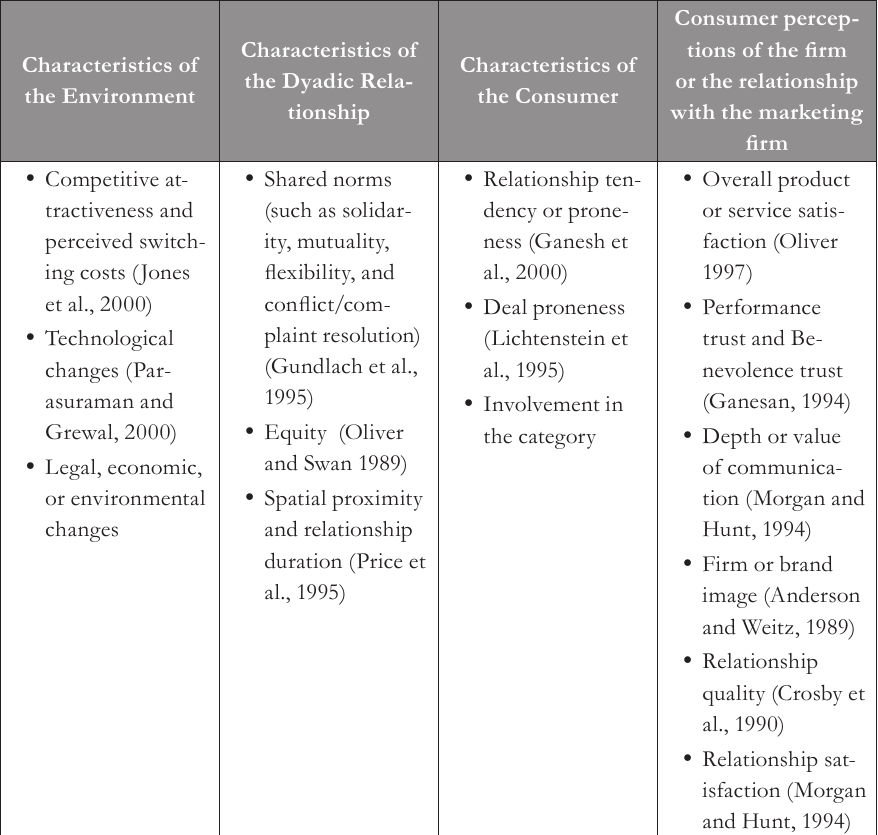
Fig. 1 - Classification of Customer Loyalty Antecedents. Source: Ball et al.